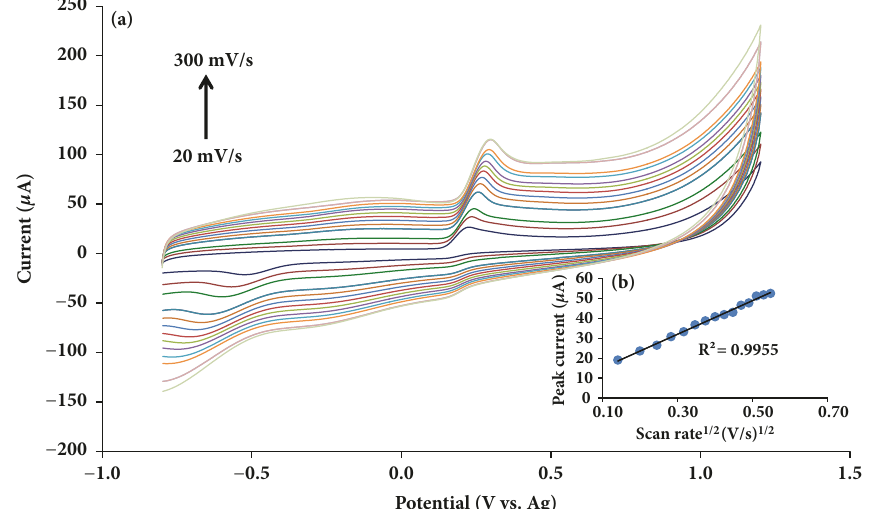
Figure 3: (a) Cyclic voltammograms of 1 mM uric acid in 0.1 M PBS pH 6.0 on PDA-rGO/Au with various scan rates 20, 40, 60, 80, 100, 120, 140, 160, 180, 200, 220, 240, 260, 280, and 300 mV s - 1 . (b) Plot for the anodic peak current versus the square root of the scan rate ( ] 1/2 ) in the same